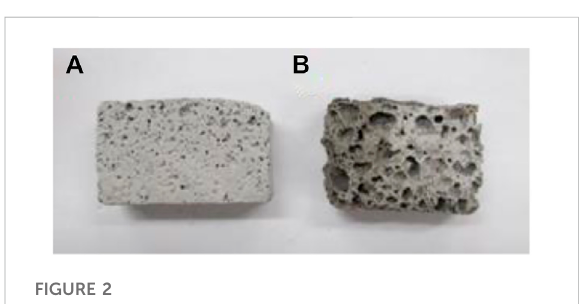
FIGURE 2 Foamed sodium (A) and potassium (B) geopolymer.